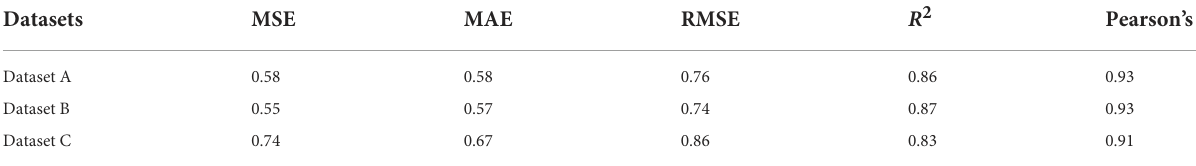
TABLE 3 Evaluation metric values in the training cohort.